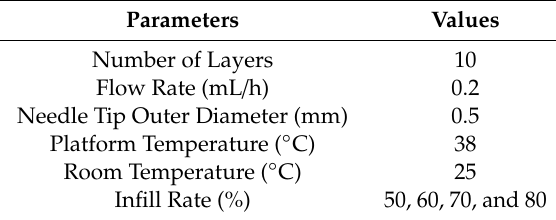
Table 2. Process parameters for 3D printing of sca ff olds.